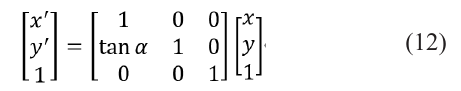
Figure 4 (a) showed examples of horizontal shear. Vertical shear. In contrast to horizontal shear, vertical shear is defined as changing location of each point in the image vertically, along the y-axis. And the amount of displacement along the y-axis is determined by each point’s coordinate of x-axis. The affine transformation matrix of vertical shear could be written as Therefore, we obtain the transformed coordinates as follows.